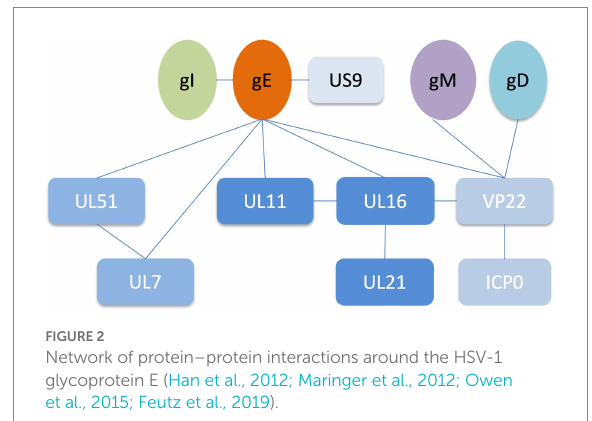
FIGURE 2 Network of protein–protein interactions around the HSV-1 glycoprotein E (Han et al., 2012; Maringer et al., 2012; Owen et al., 2015; Feutz et al.,